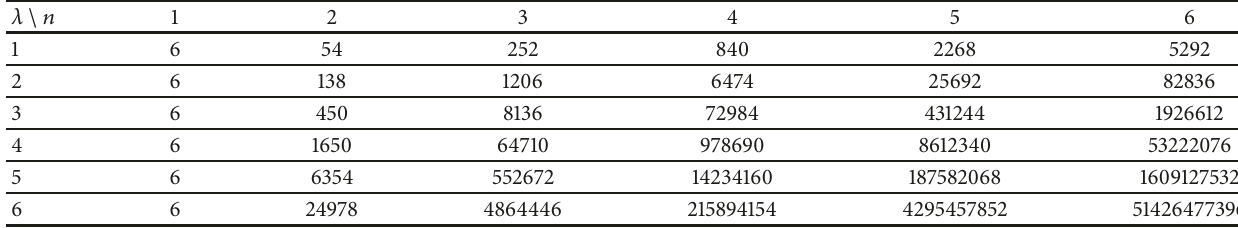
Table 2: Modified hyper Wiener index of 𝑇𝑂𝑋 .